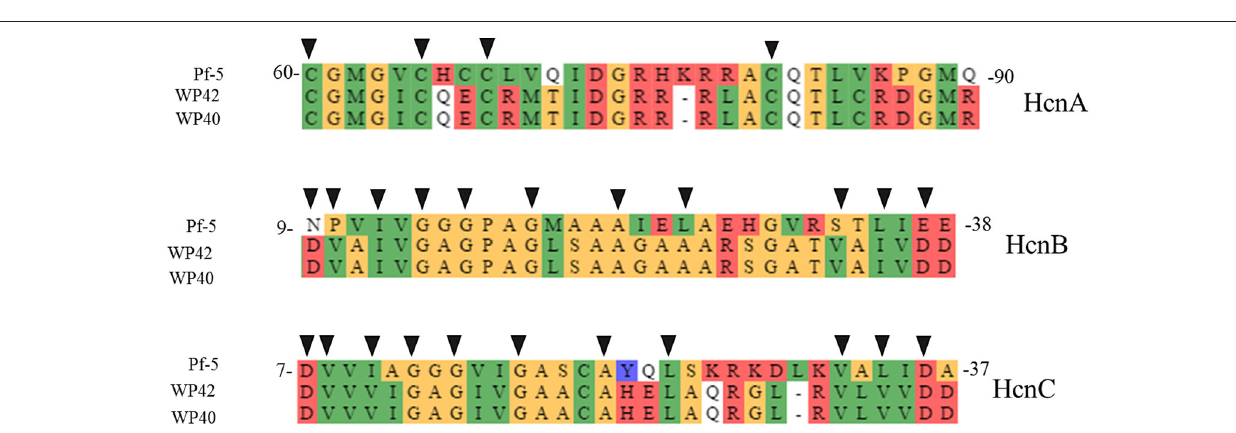
1978). The dual plate assays displayed variable